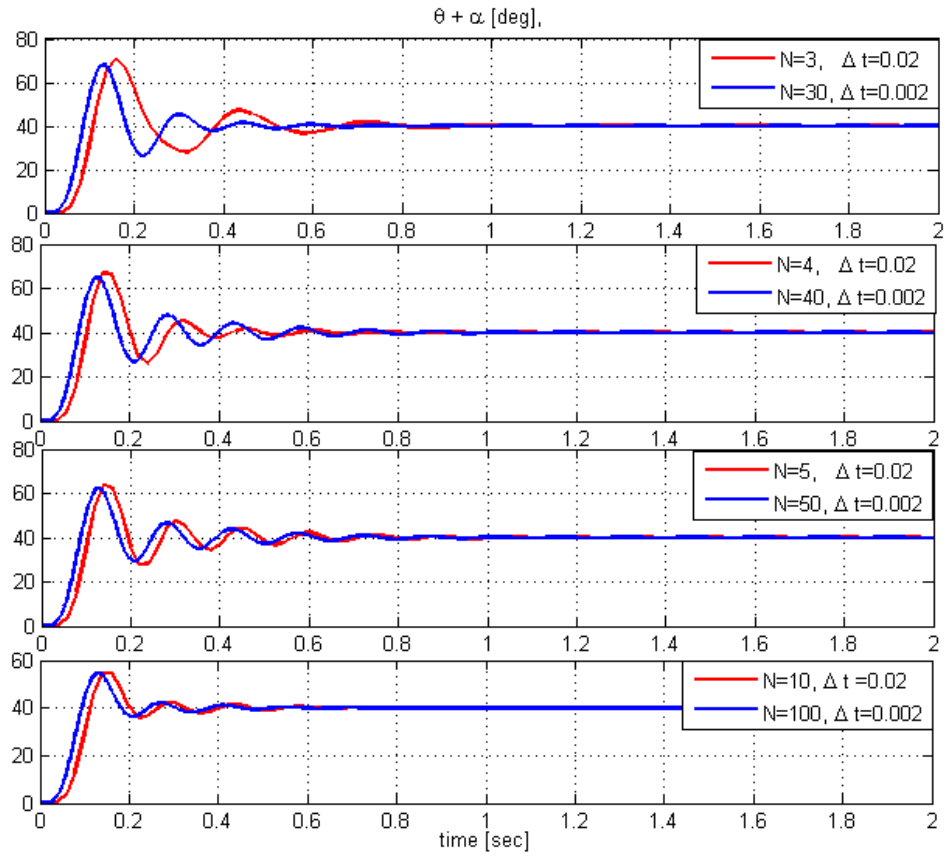
Figure 6. effect of sampling time in system’s